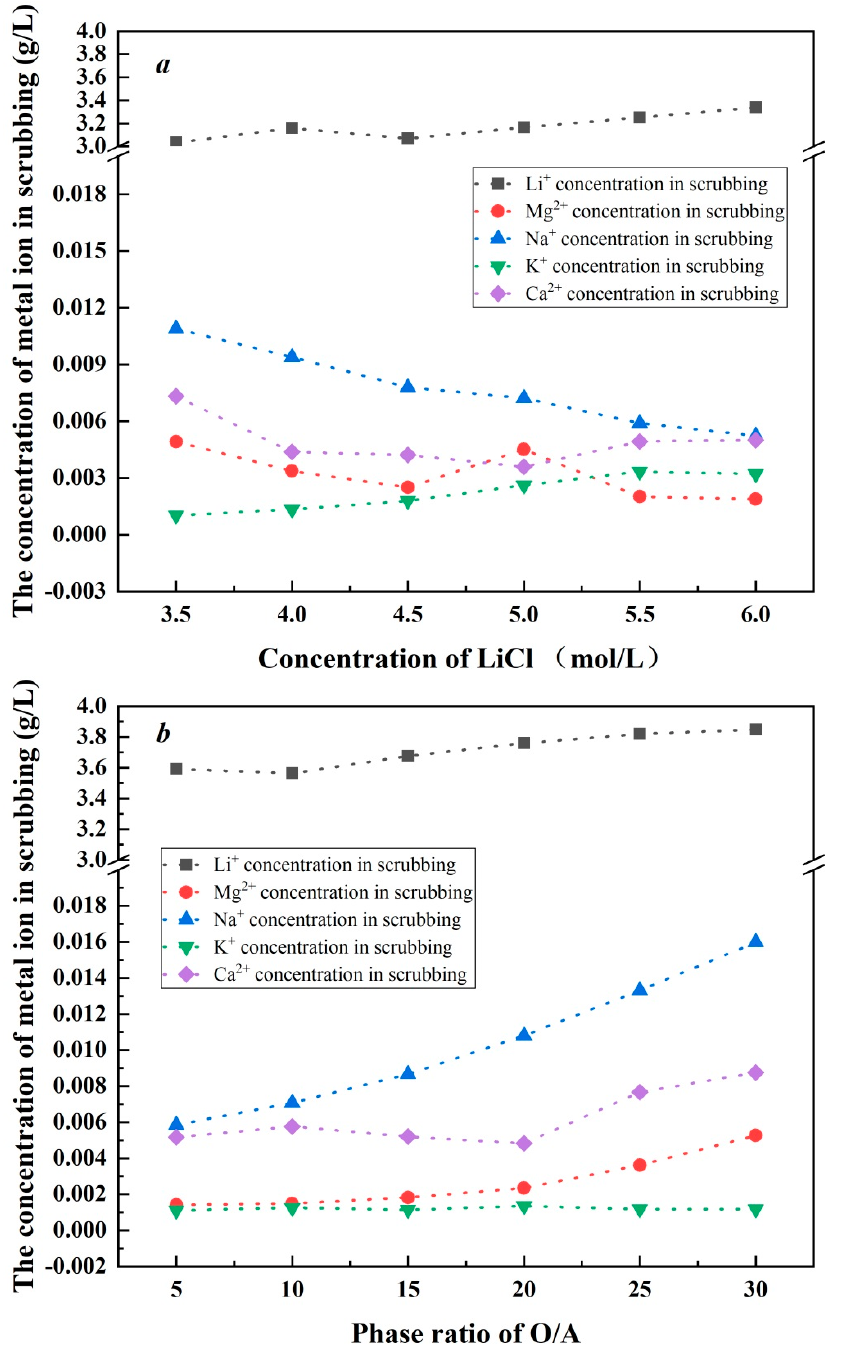
Figure 6. Effect of scrubbing condition.(( a ) means the effect of concentration of LiCl and ( b ) means the effect of phase ratio of O/A). the effect of phase ratio of